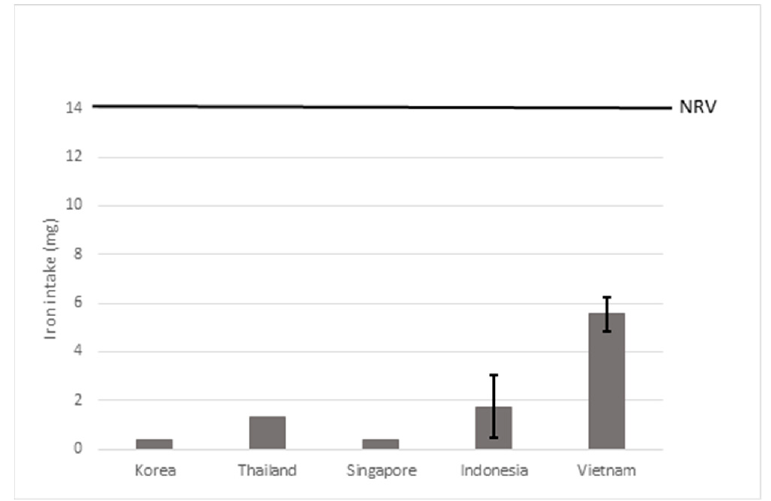
Figure 7. Estimated iron intake after hypothetical fortification of seasonings and bouillon cubes with iron fortification levels of 1 mg/g product. The error bars represent the highest and lowest value found for the country. NRV = Codex nutrient reference value of 14 mg/day.